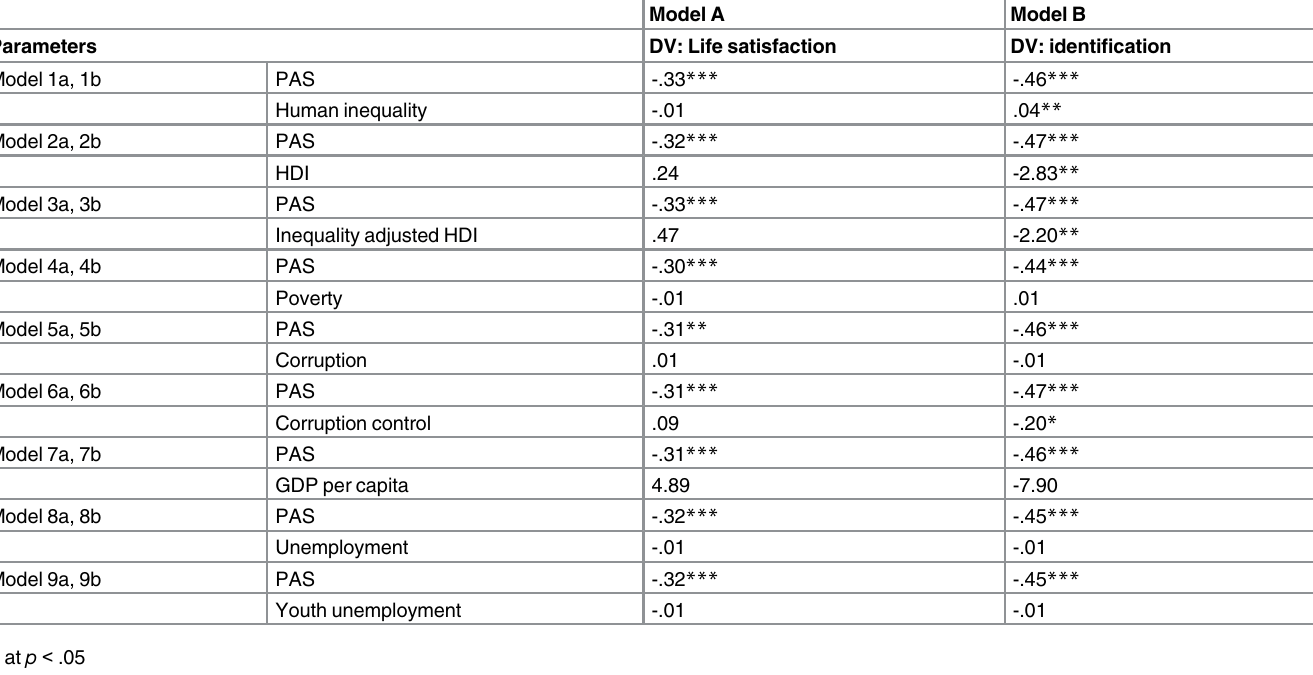
Table 7. Multilevel regression predicting life satisfaction and national